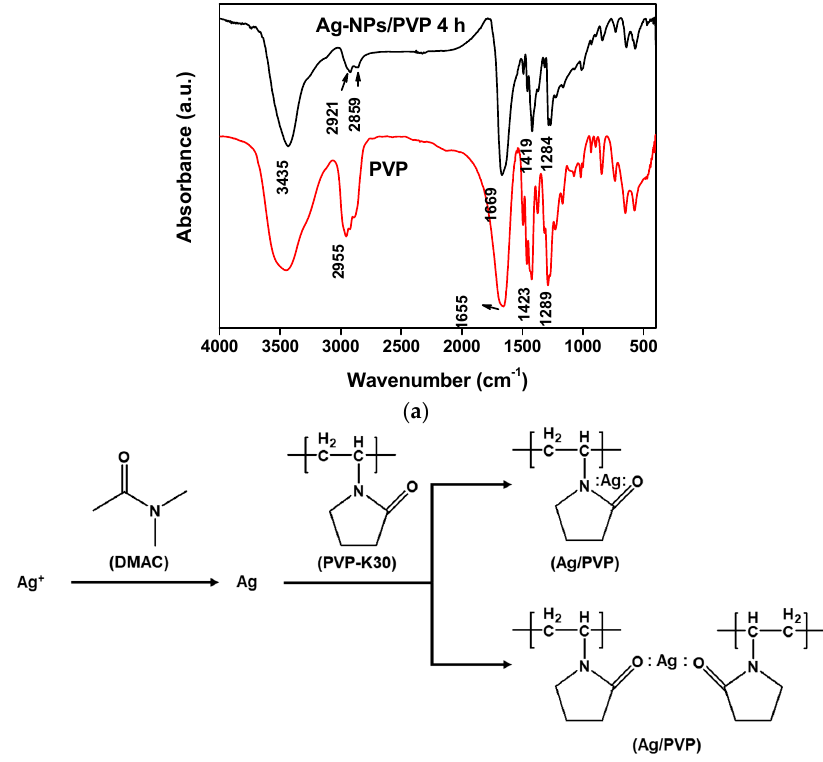
Figure 2. Chemical structure of Ag ‐ NPs/PVP: ( a ) FTIR spectra of PVP and Ag ‐ NPs/PVP reacted for 4 h; ( b ) the major reaction scheme of Ag/PVP.